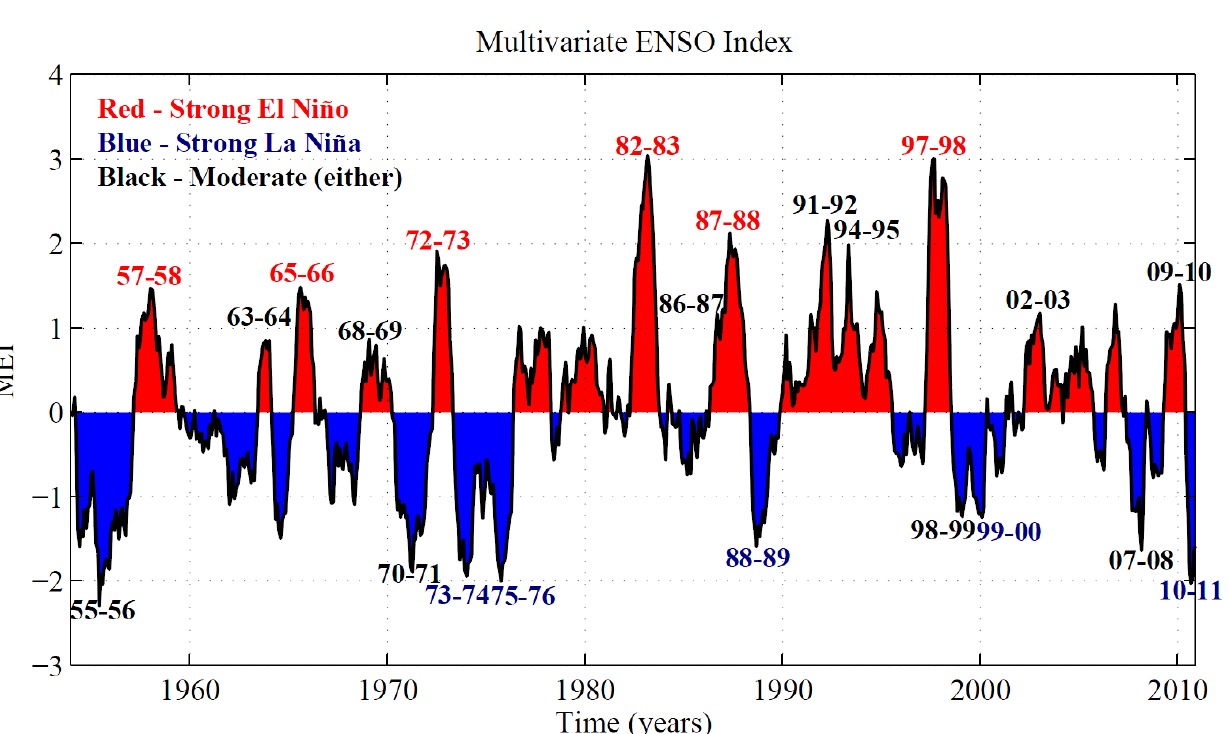
Figure 2. Multivariate ENSO indices from 1954 to 2010. El Niño (positive phase) in red; La Niña (negative phase) in blue. Numbers on the plot show El Niño/La Niña event years. Red and blue digits denote strong El Niño and La Niña events respectively. Black digits show the moderate years for either